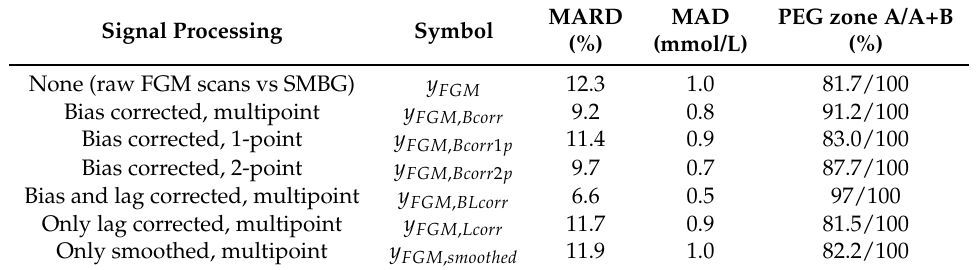
Table 2. Influence on overall MARD of different signal processing of day 1 data to correct for bias and lag.